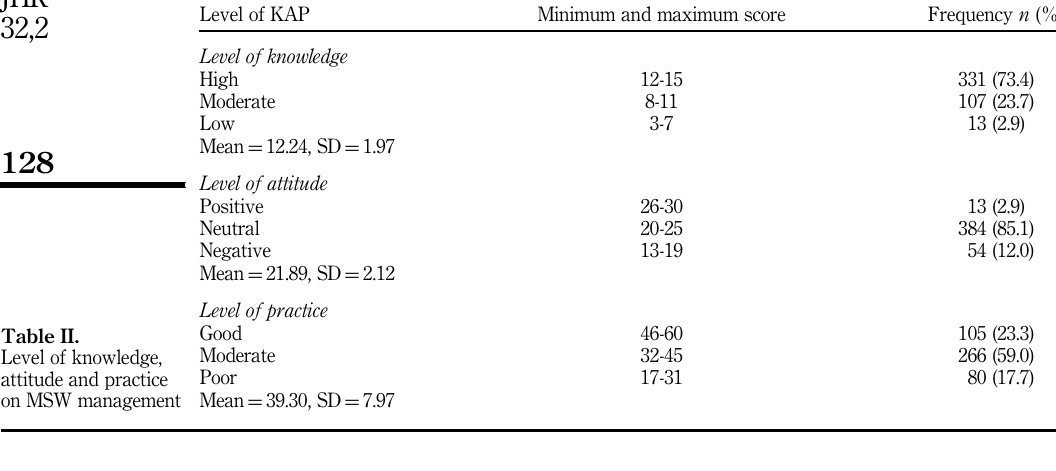
attitude and practice on MSW management